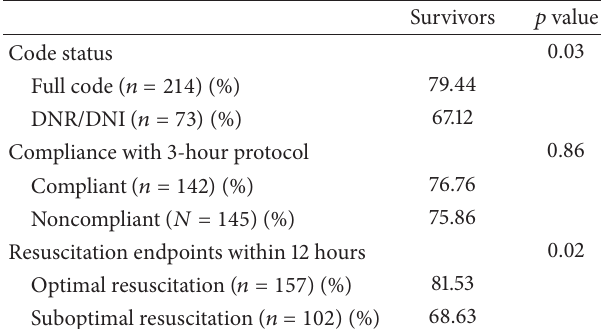
Table 5: Subgroup analysis of